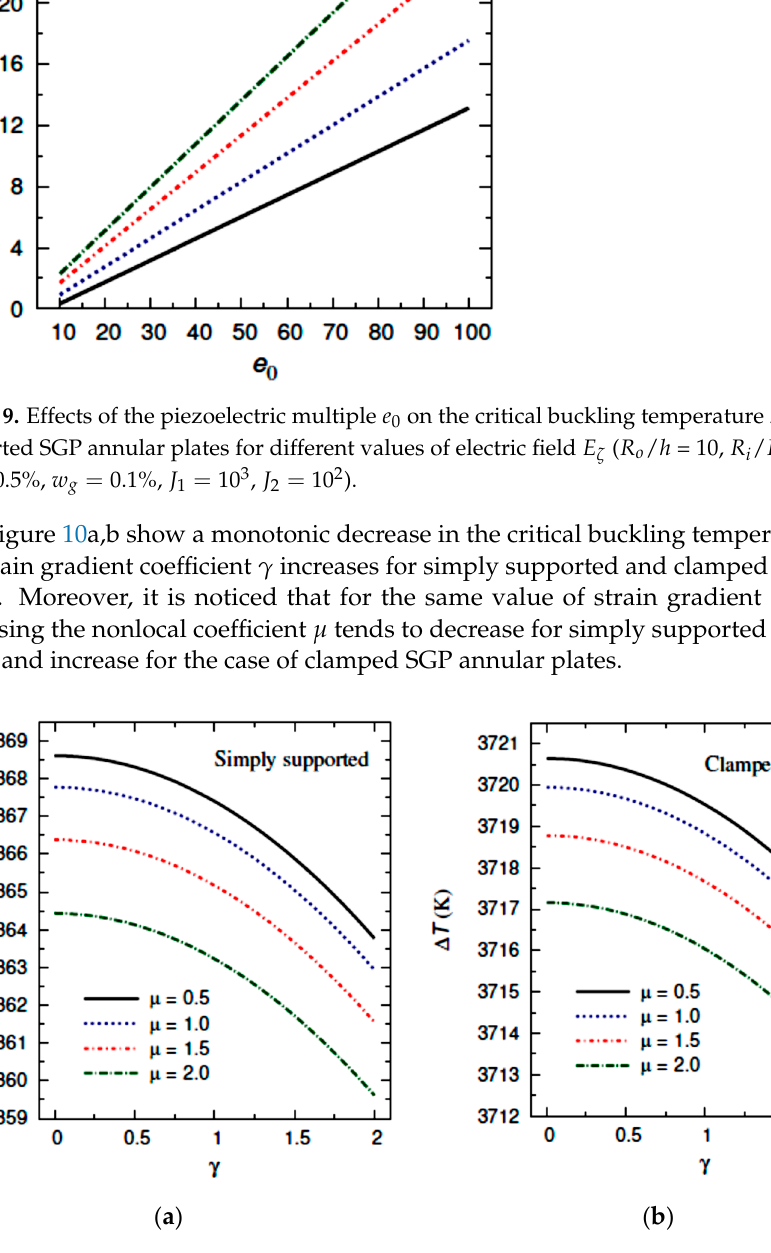
Figure 8. Critical buckling temperature Δ𝑇 (cid:3030)(cid:3045) of ( a ) simply supported plates versus the ratio 𝑅 (cid:3042) /ℎ , ( b ) clamped plates versus the ratio 𝑅 (cid:3042) /ℎ , ( c ) simply supported plates versus the ratio 𝑅 (cid:3036) /𝑅 (cid:3042) and ( d ) clamped plates versus the ratio 𝑅 (cid:3036) /𝑅 (cid:3042) for different values of electric field ( 𝜅 = 1 , Δ𝐶 = 0.5% , 𝑒 (cid:2868) = 10 , 𝑤 (cid:3034) = 0.1% , 𝜇 = 𝛾 = 2 nm , 𝐽 (cid:2869) = 1000 , 𝐽 (cid:2870) = 100 ).